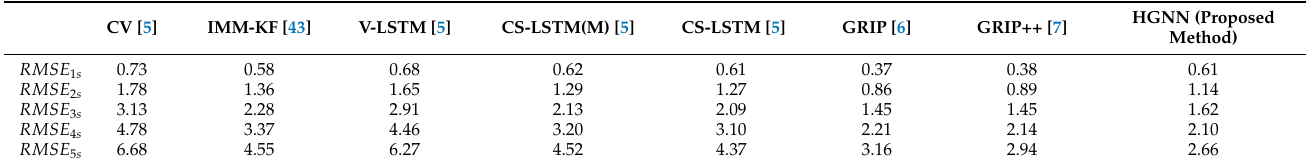
Table 2. Comparison of RMSE errors with other baseline methods.